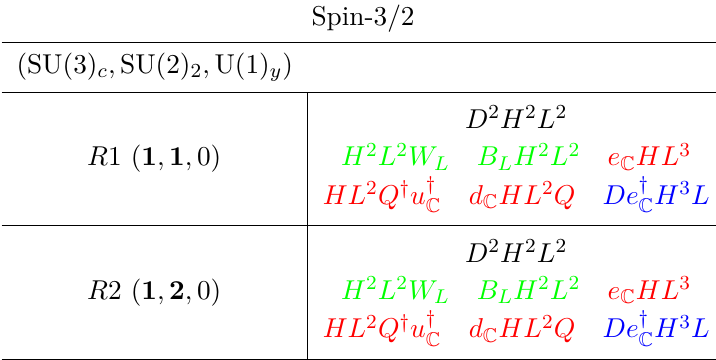
Table 21 . Spin-3/2 resonances which could generate the dim-6